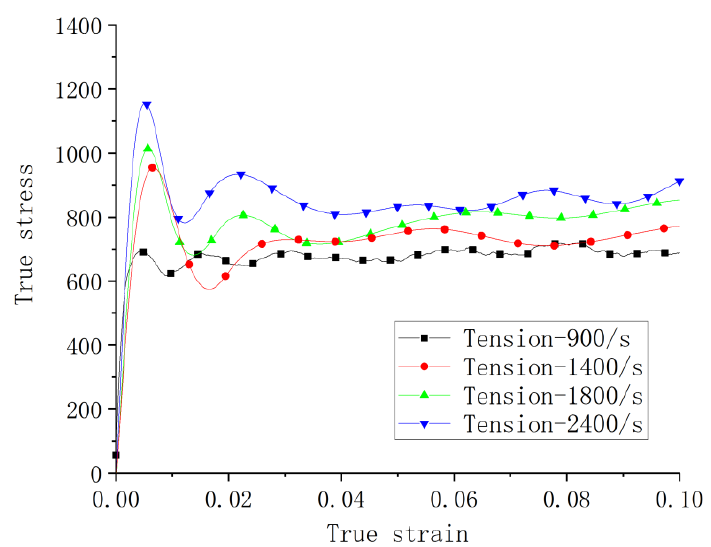
Figure 13. Stress–strain curves of different strain rates in dynamic tensile tests at room temperature.